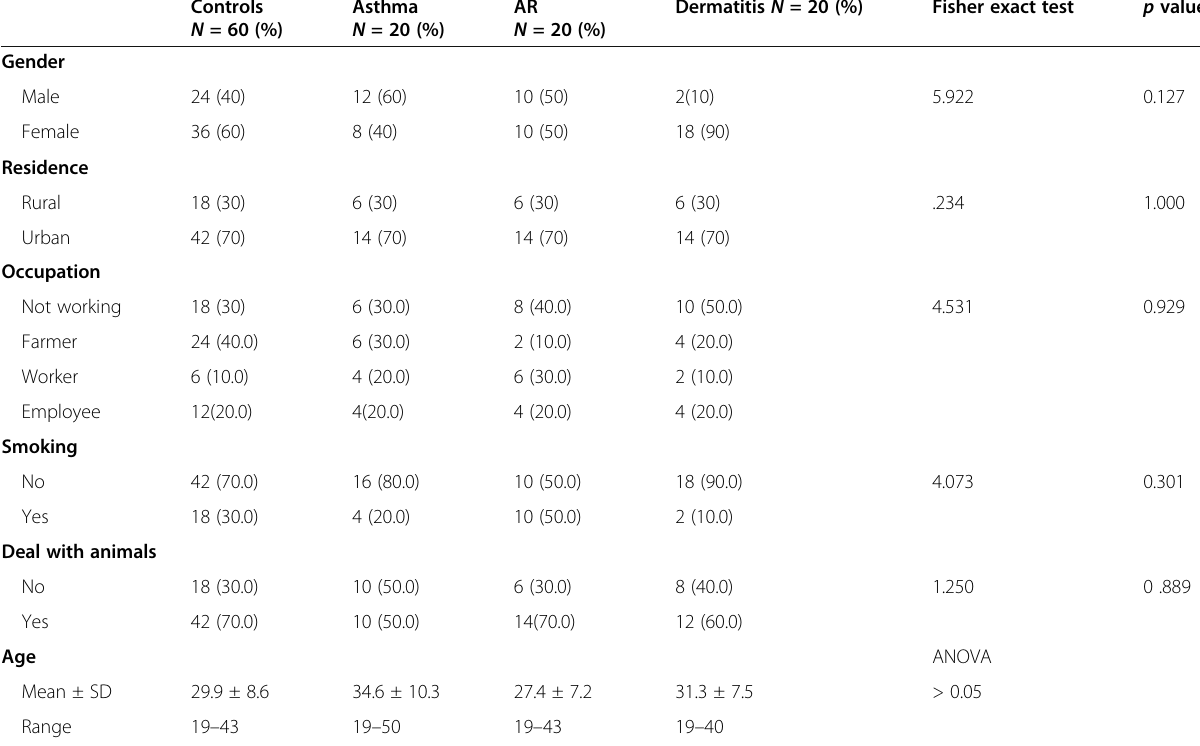
Table 3 Comparison of the studied groups regarding demographic